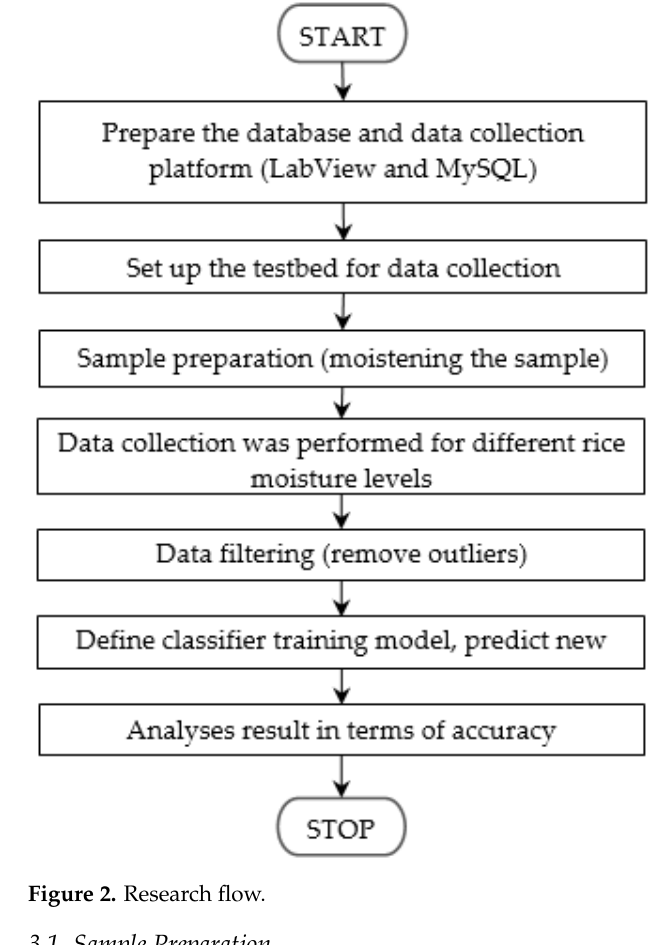
Figure 2. Research flow.